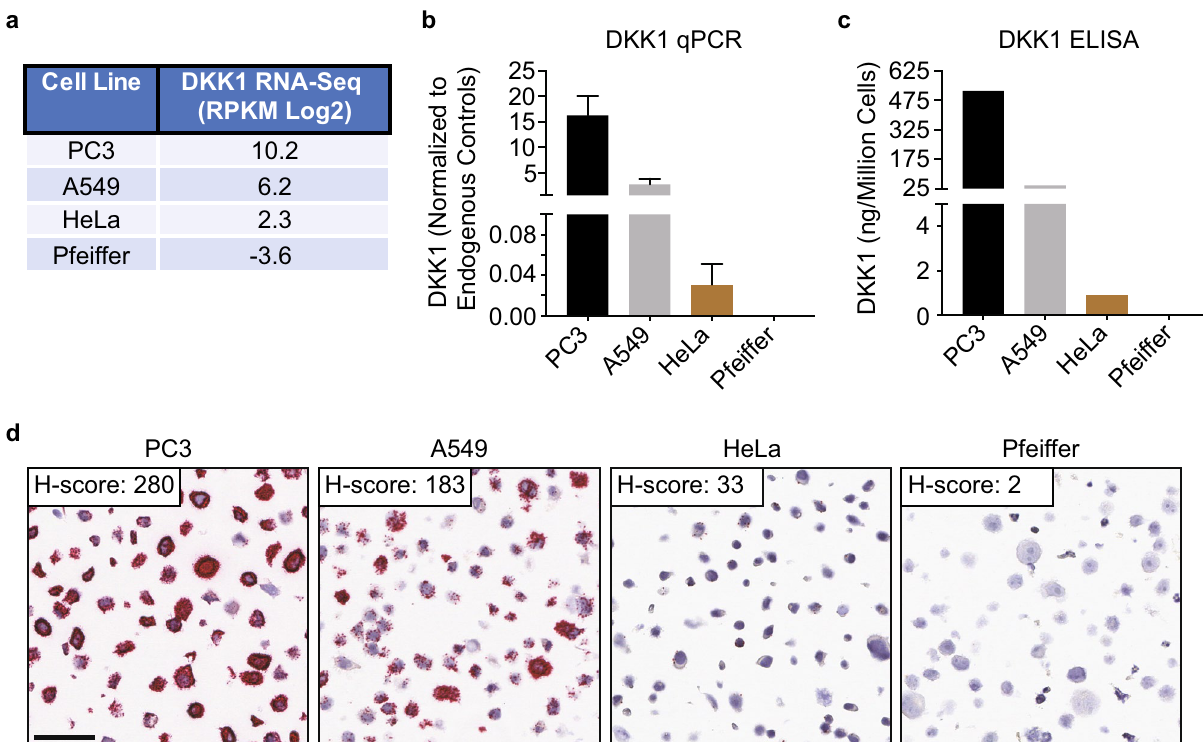
Figure 1. Initial assessment of the DKK1 RNAscope assay. ( a ) Four cell lines that express a dynamic range of DKK1 from very high to none were identified using RNA-Seq data from the Cancer Cell Line Encyclopedia database. Reads per kilobase per million mapped reads (RPKM). ( b , c ) DKK1 expression in the indicated cell lines was verified by qPCR and ELISA. DKK1 qPCR data was normalized to GAPDH, TBP, and SDHA housekeeping genes. ( d ) DKK1 RNAscope staining of the control FFPE cell pellet array containing the indicated cell lines. Red dots are indicative of DKK1 signal with each dot corresponding to a single RNA molecule. DKK1 signal was quantified using QuPath morphometric software and an H-score (range 0–300) was calculated as described in the methods. Scale bar: 50